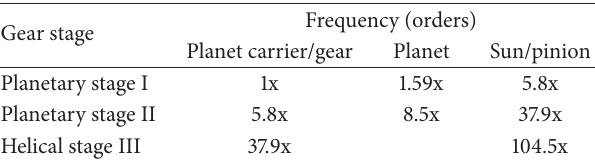
Table 5: Rotational frequencies for each